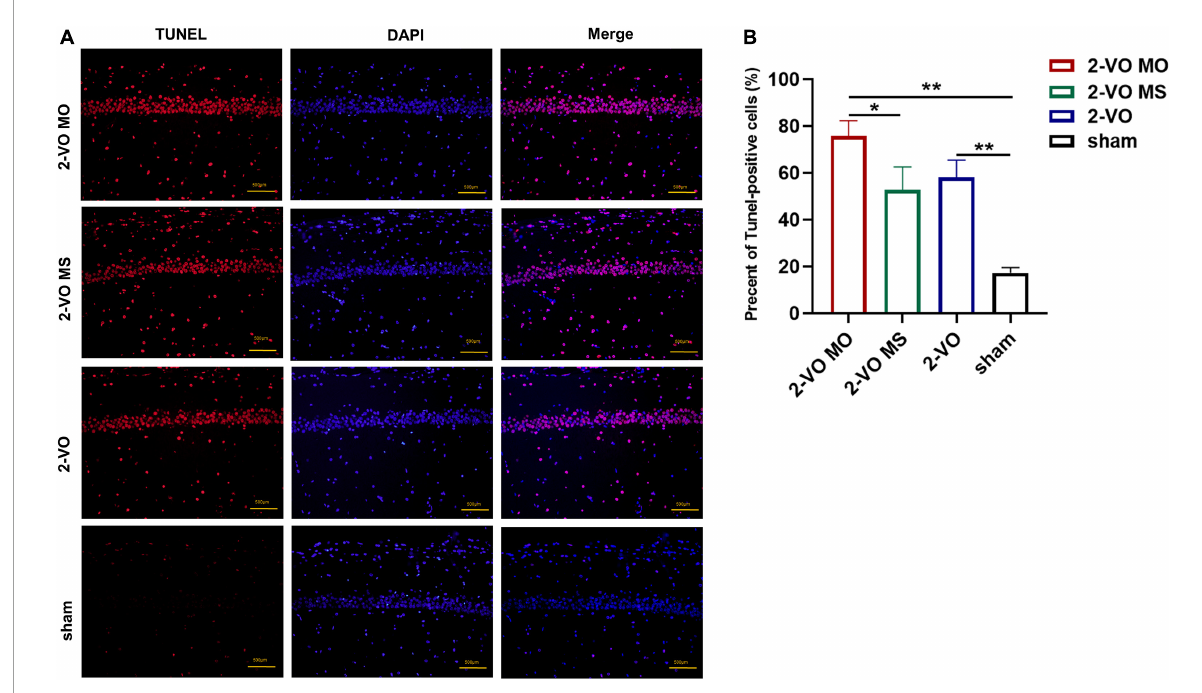
FIGURE4 TUNEL staining of CA1 region of rat hippocampus. (A) Cell nuclei (blue), the red spots represent TUNEL-positive cells. (B) The TUNEL-positive rate in CA1 quantification ( × 200, the positive rate is expressed as mean ± SD, n = 4, * p < 0.05, ** p <